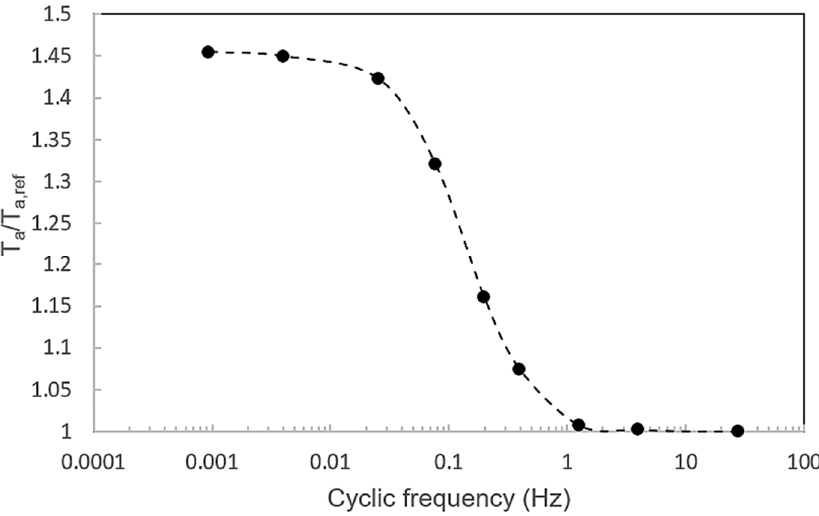
Figure 14. Effect of cyclic frequency on anchor capacity for 30 cycles applied.